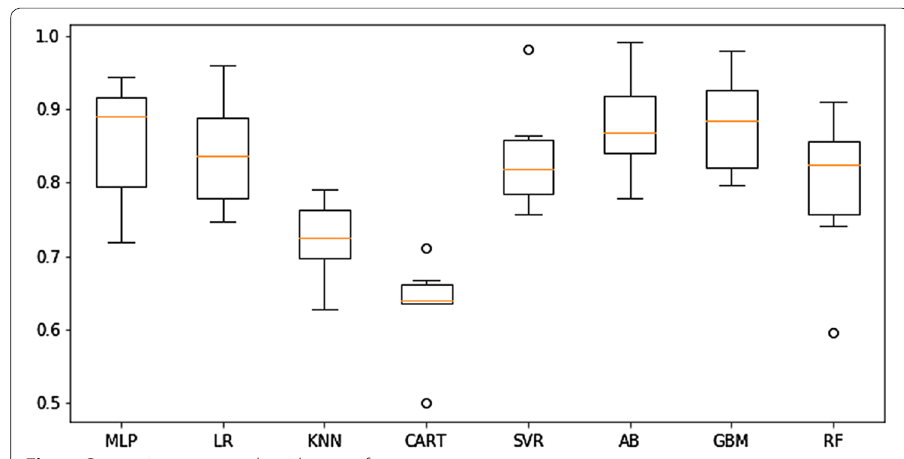
Fig. 5 Comparison among algorithms performances